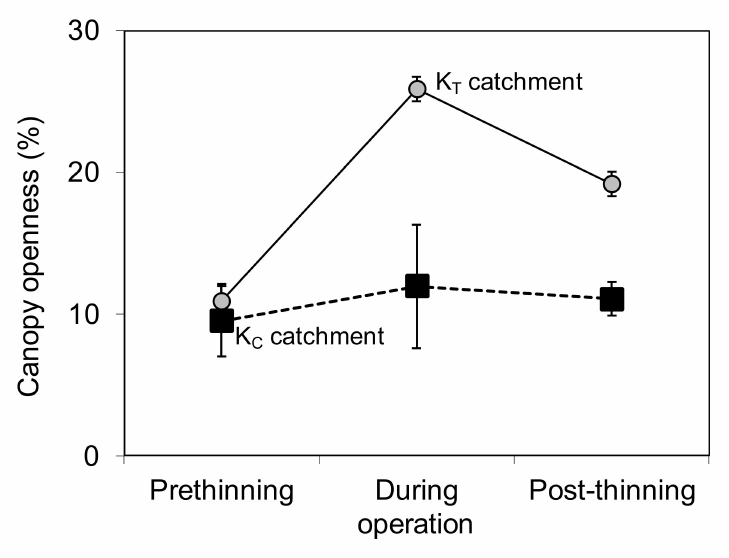
Figure 3. The changes in canopy openness (%) in the treated (K T ) and control (K C ) catchments during our monitoring period. Prethinning, during-operation, and post-thinning canopy openness was measured on 16 December 2010, 16 December 2011, and 4 December 2012,